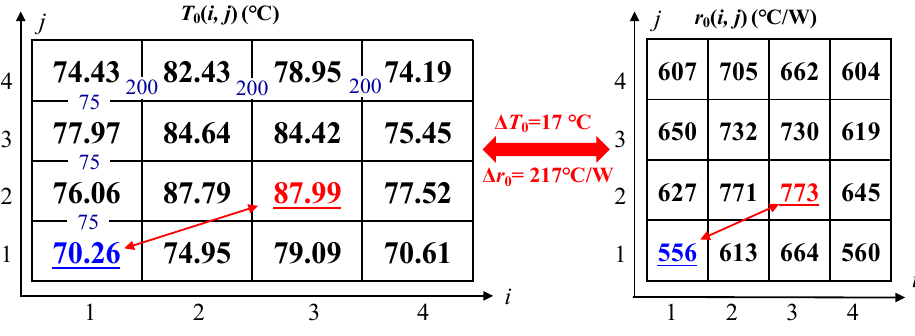
Figure 10. ( a )Thermal modeling of proposed bias PA; ( b )Temperature distribution of thermal simulation.